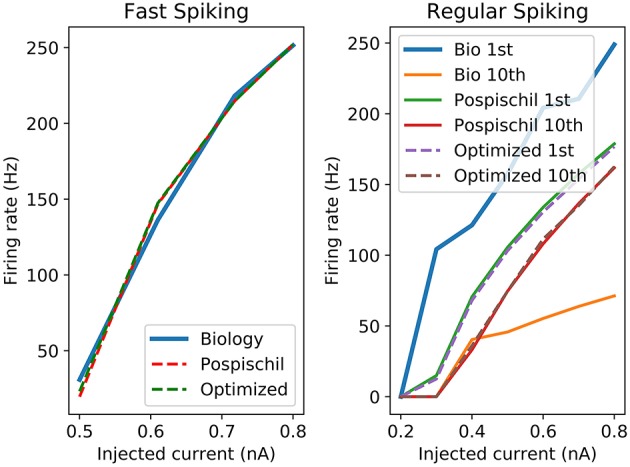
Left graph shows the F-I curve of the biological cell recordings (Blue curve named Biology), original model (red dotted line named Pospischil) from Pospischil et al. (2008) and the optimized model proposed in this paper (green dotted in named Optimized); Right graph shows the frequency of the first and 10th spike of the original and optimized equations compared to the biological cell.